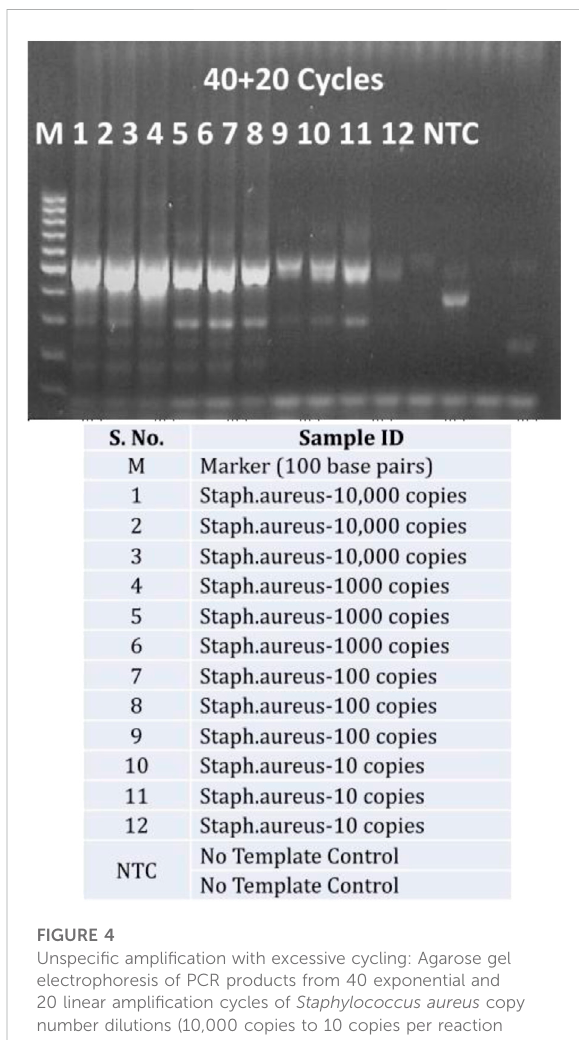
FIGURE 4 Unspeci fi c ampli fi cation with excessive cycling: Agarose gel electrophoresis of PCR products from 40 exponential and 20 linear ampli fi cation cycles of Staphylococcus aureus copy number dilutions (10,000 copies to 10 copies per reaction and No Template control-NTC) against a 100 bps